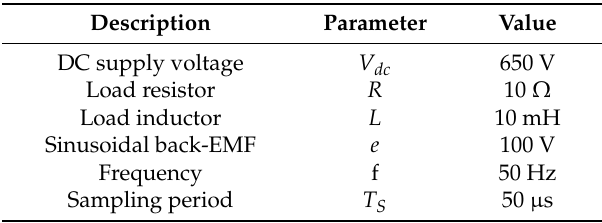
Table 3. Parameters for VSI